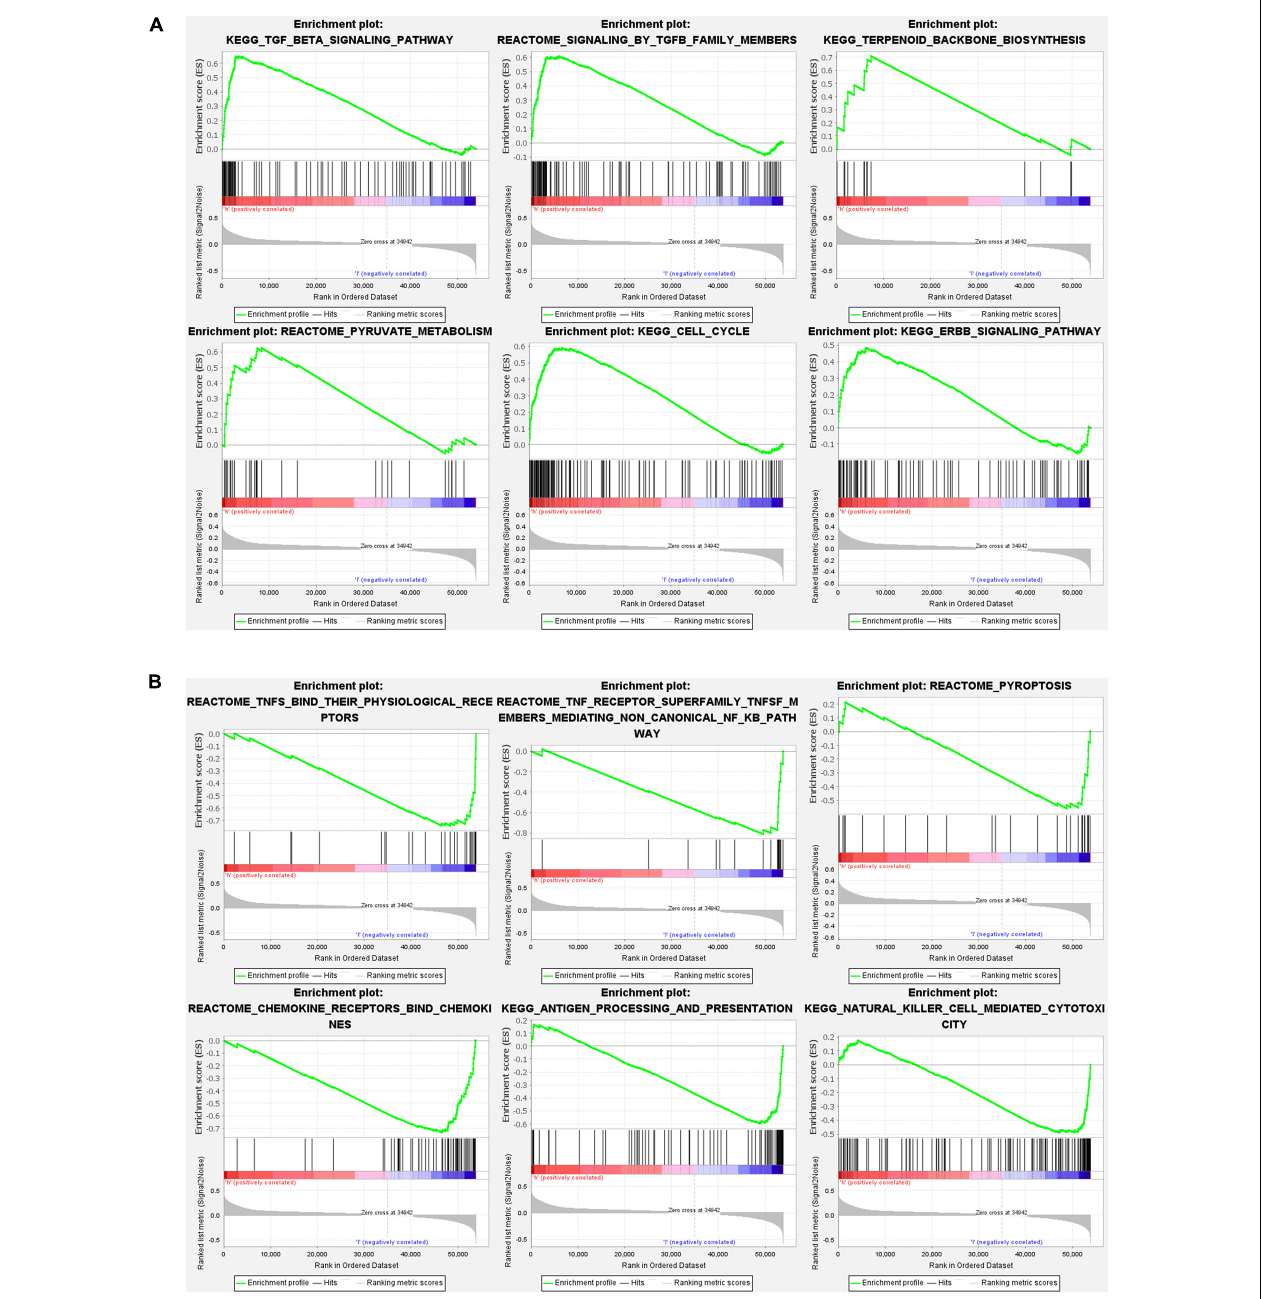
FIGURE 6 | Gene set and function enrichment analysis of differentially expressed genes between the high-risk group and low-risk group. (A) TGF- β signaling pathway, terpenoid backbone biosynthesis, pyruvate metabolism, cell cycle, and ERBB signaling pathway are enriched in the high-risk group. (B) TNFs bind their physiological receptors, TNF receptor superfamily TNFSF members mediating non-canonical NF-kB pathway, pyroptosis pathway, chemokine receptors bind chemokines pathway, antigen processing and presentation pathway, and NK cell-mediated cytotoxicity pathway are enriched in the low-risk